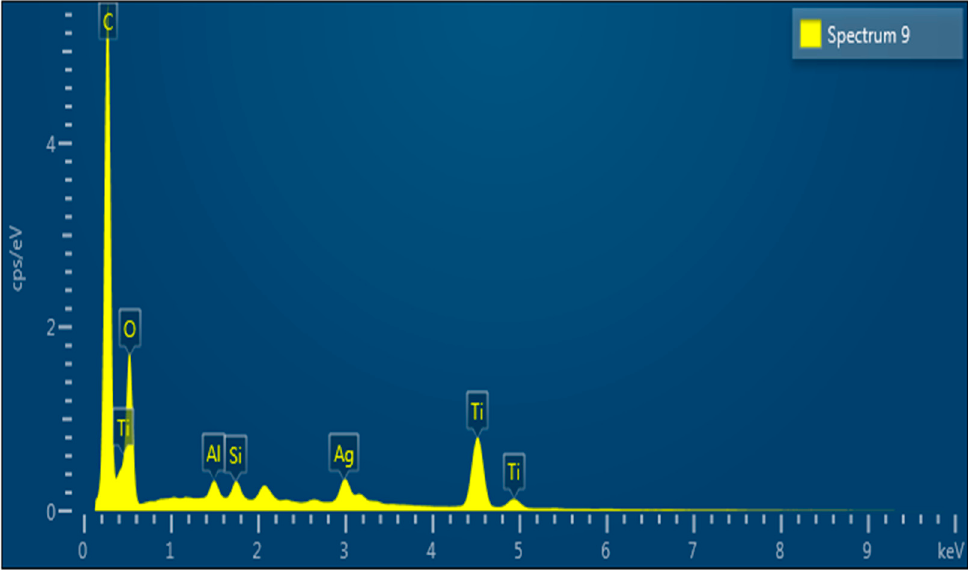
Figure 5. EDX results of (3%)Ag-TiO 2 /rGO/HNT.